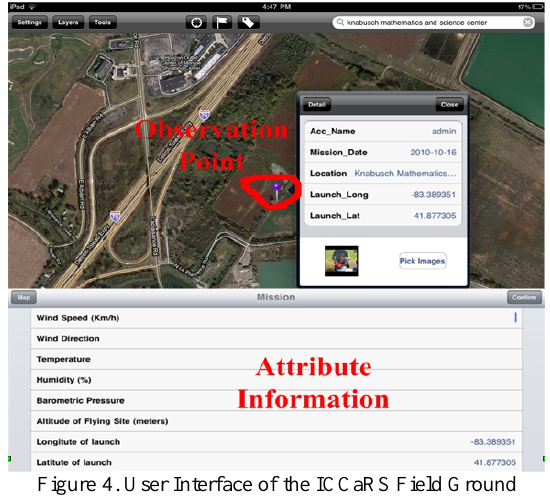
Figure 4. User Interface of the ICCaRS Field Ground Truthing Data